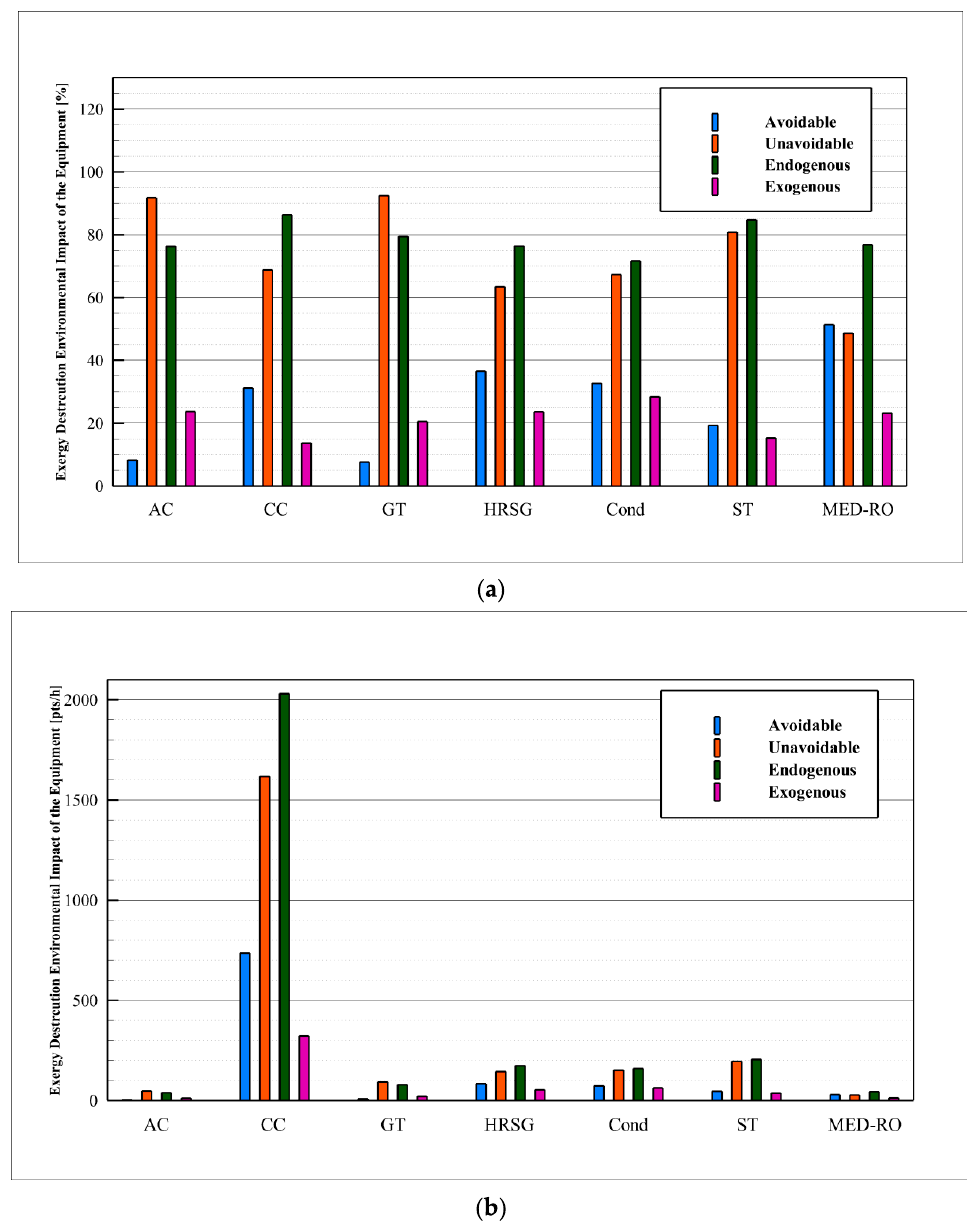
Figure 8. Distributions of avoidable/unavoidable and endogenous/exogenous environmental impacts of exergy destruction for different system components in ( a ) relative values and ( b ) quantitative values. AC, air compressor; CC, combustion chamber; GT, gas turbine; HRSG, heat recovery steam generator; Cond, condenser; ST, steam turbine; MED-RO, multi-effect distillation and reverse osmosis